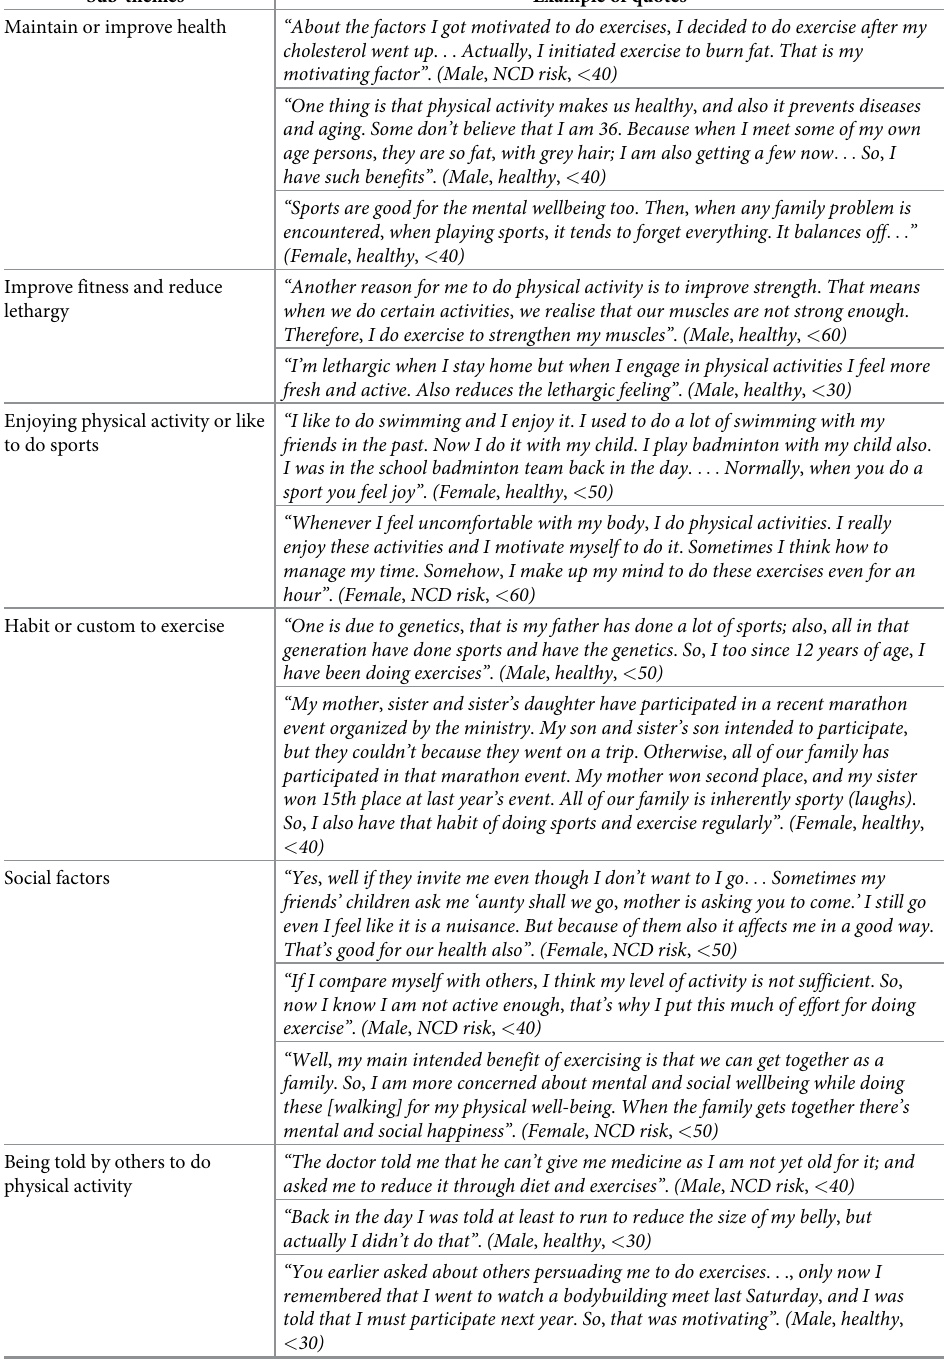
Table 3. Sub-themes on perceived facilitators of physical